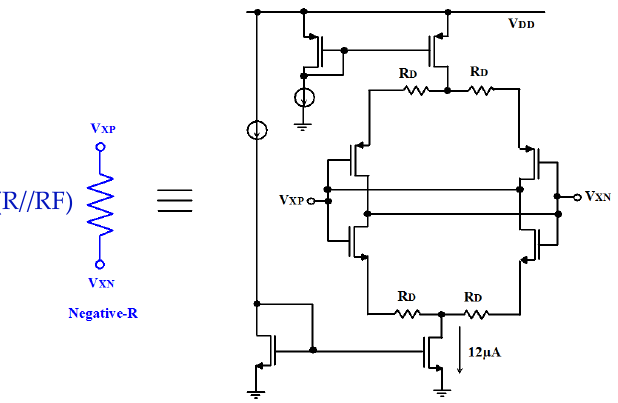
Figure 5. Negative-R circuit.